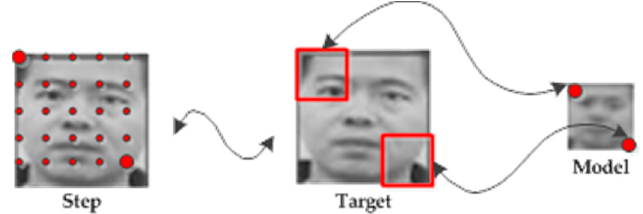
Figure 7. Brief process of the mean sampling.